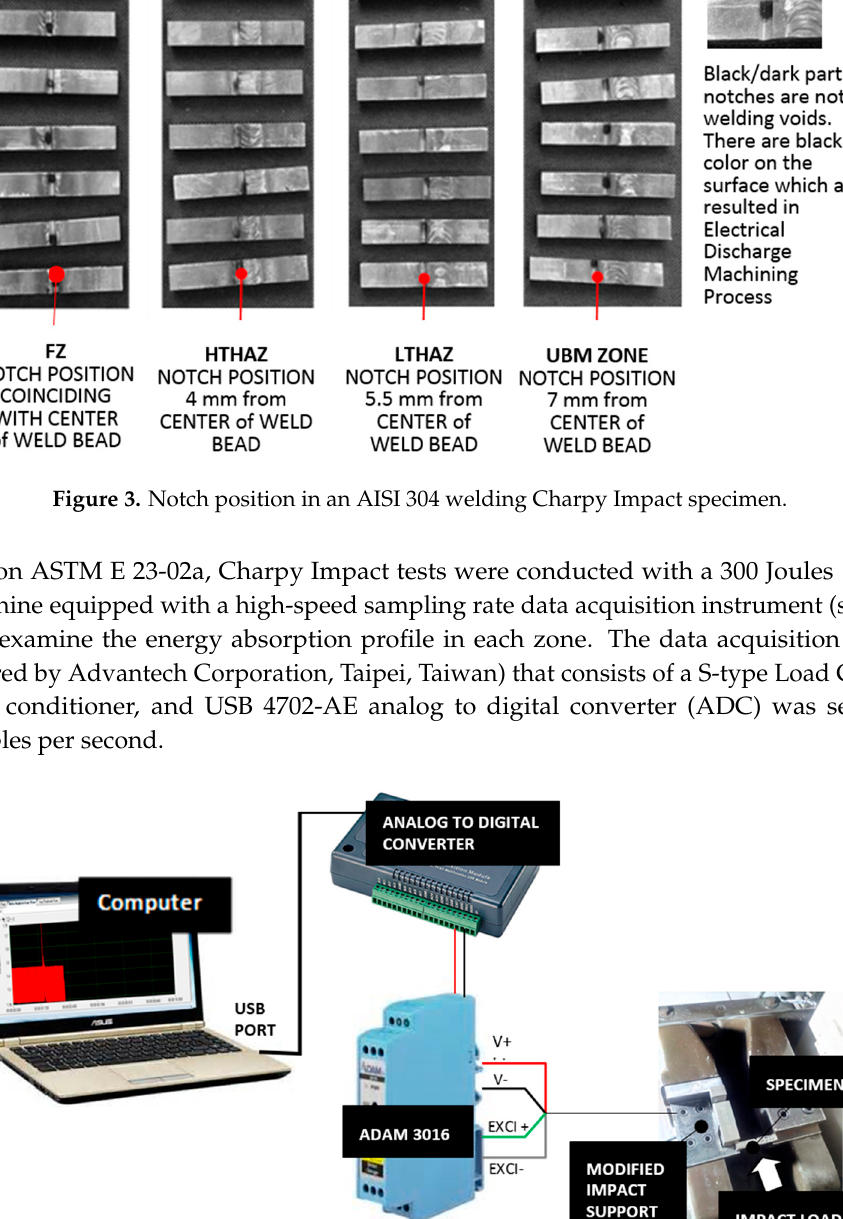
Figure 4. High-speed sampling rate data acquisition instrument.